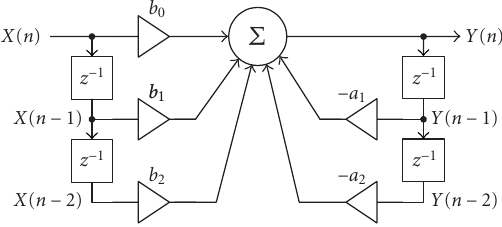
Figure 3: The architecture of an IIR biquadratic section.